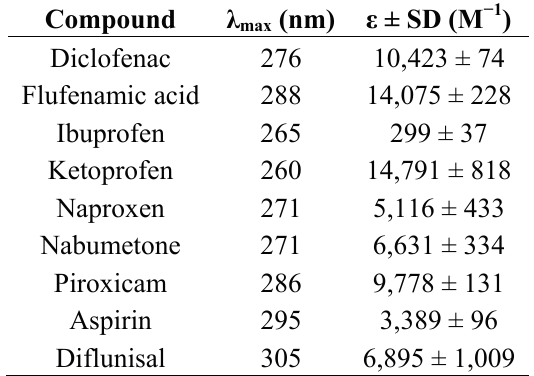
, molar extinction coefficients in pH 7.1 phosphate buffer, and standard deviations Table 2. λ max